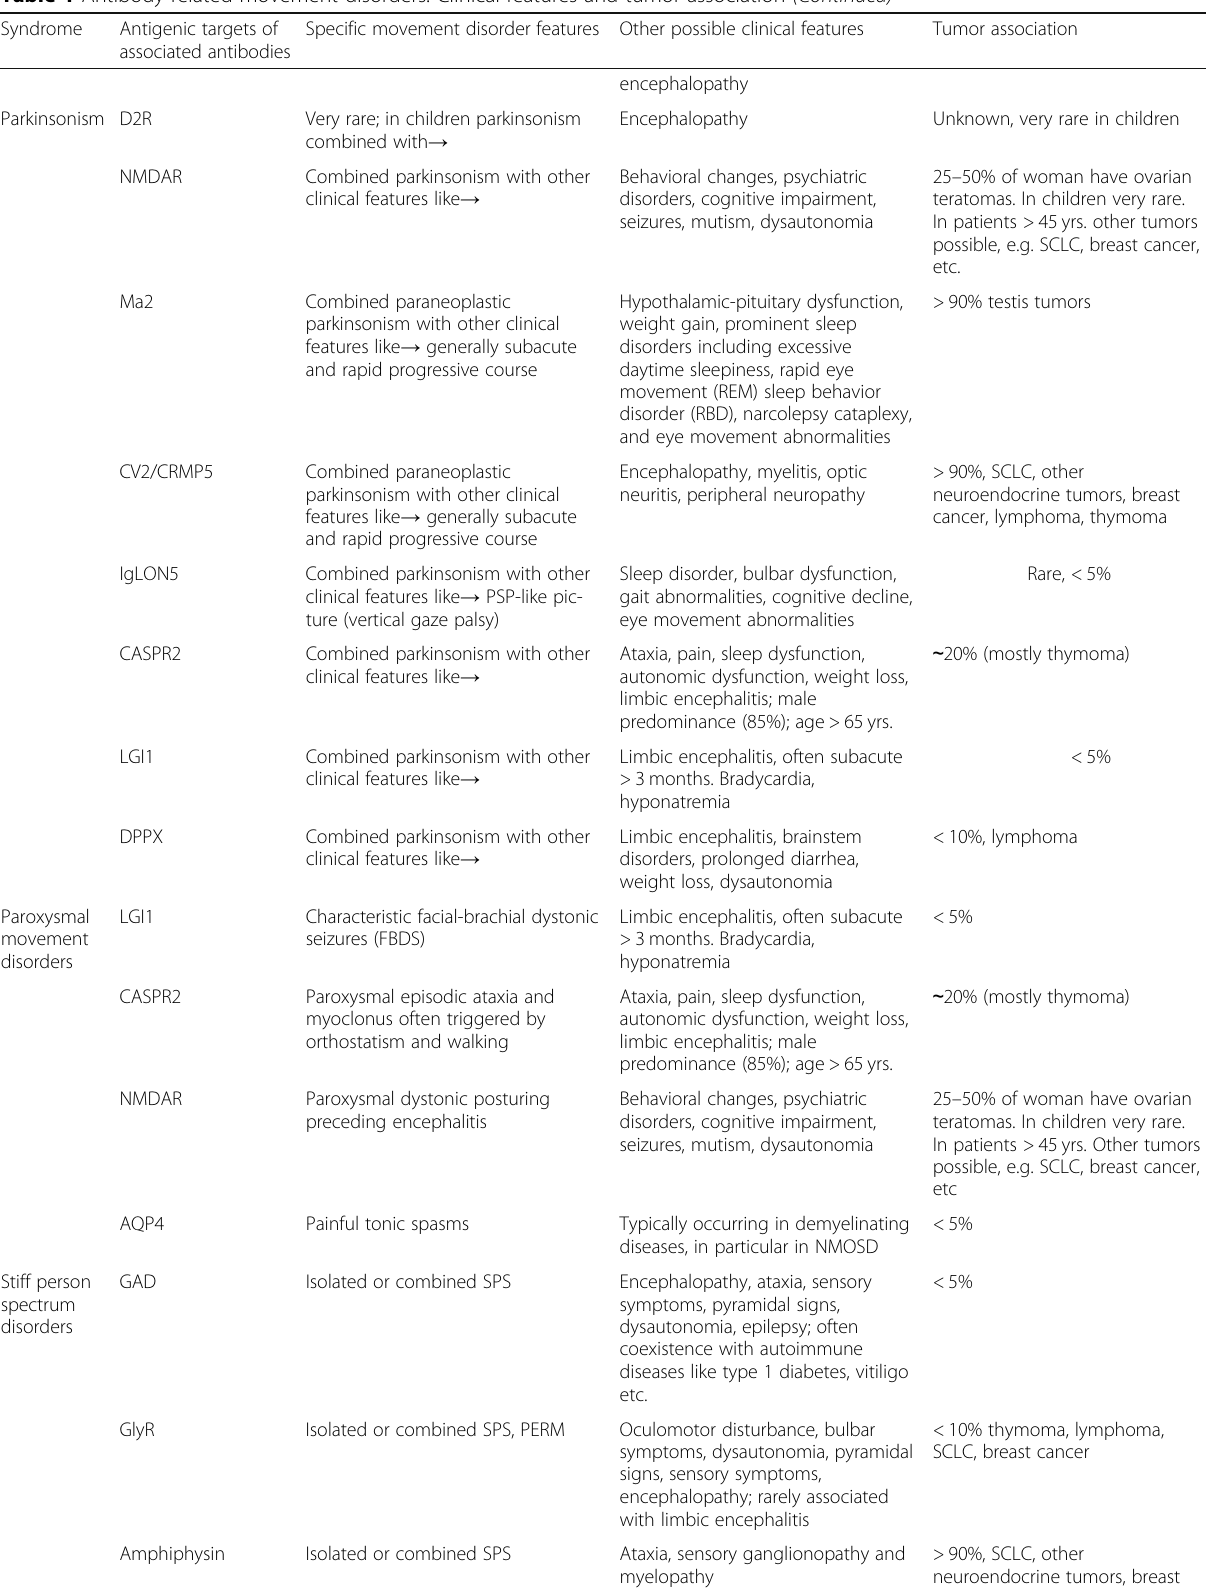
Table 1 Antibody-related movement disorders: Clinical features and tumor association (Continued)